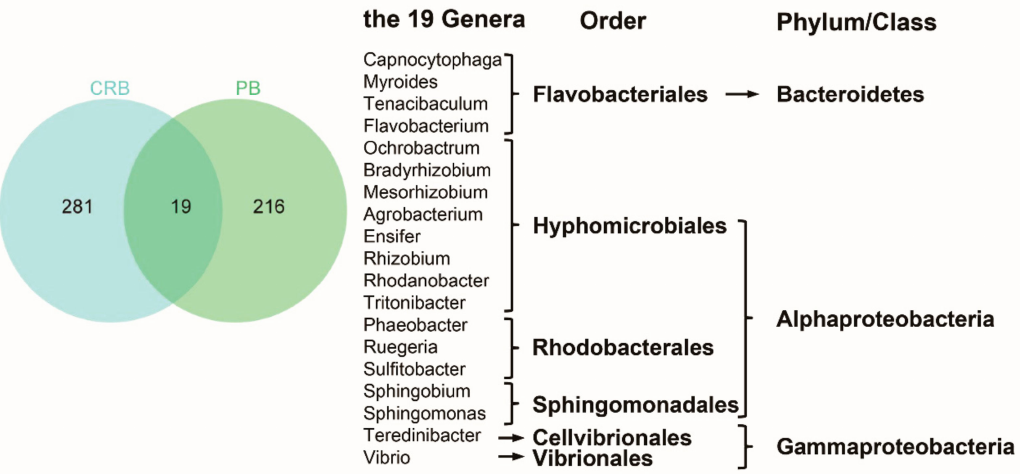
Figure 6. The characteristics of overlapping regions of the putative chlorine-resistant bacteria (CRB) and phycospheric bacteria (PB) and the typical